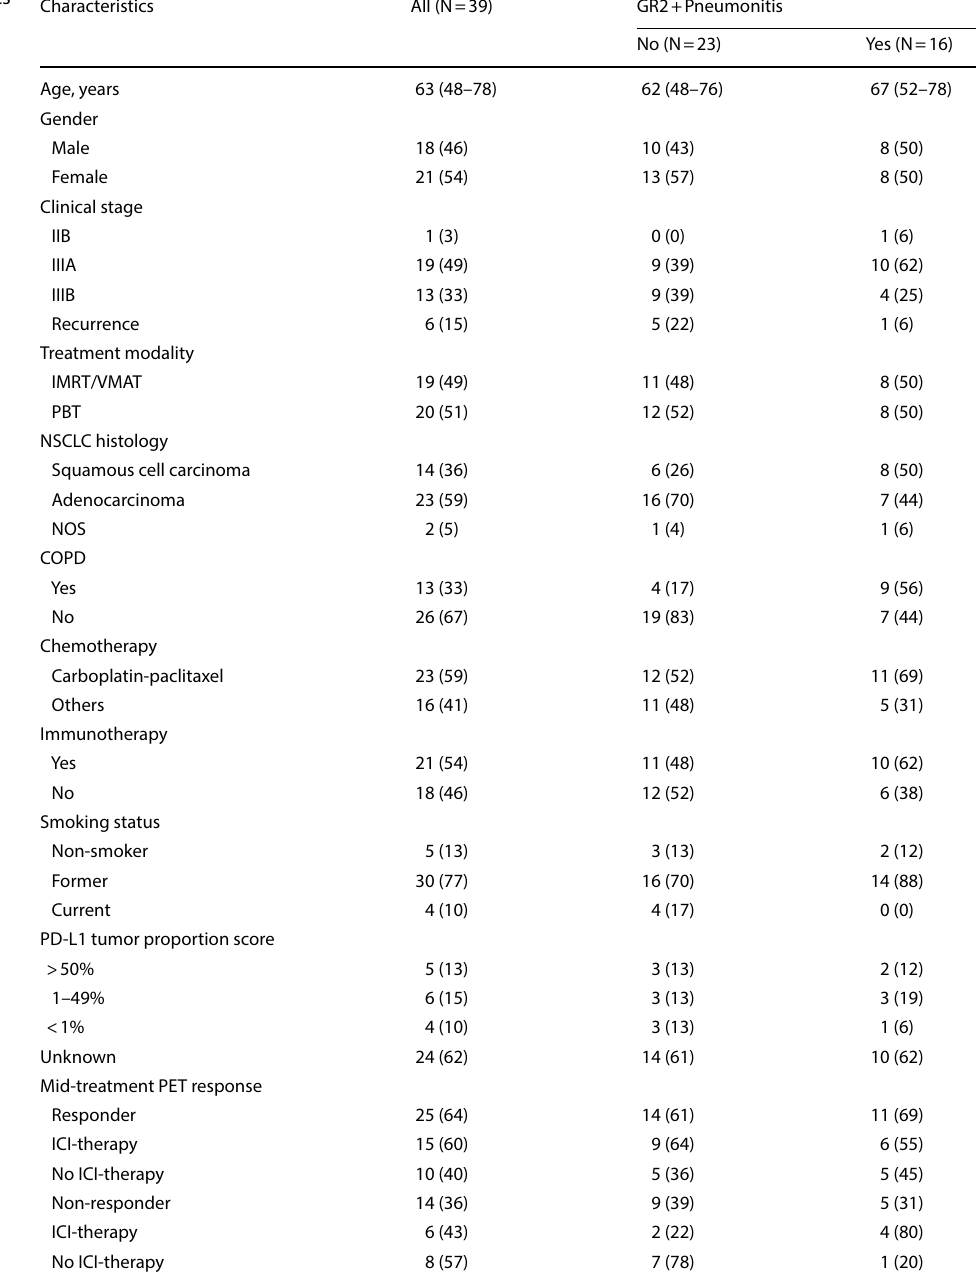
Table 1 Patient demographics and clinical characteristics stratified by pneumonitis